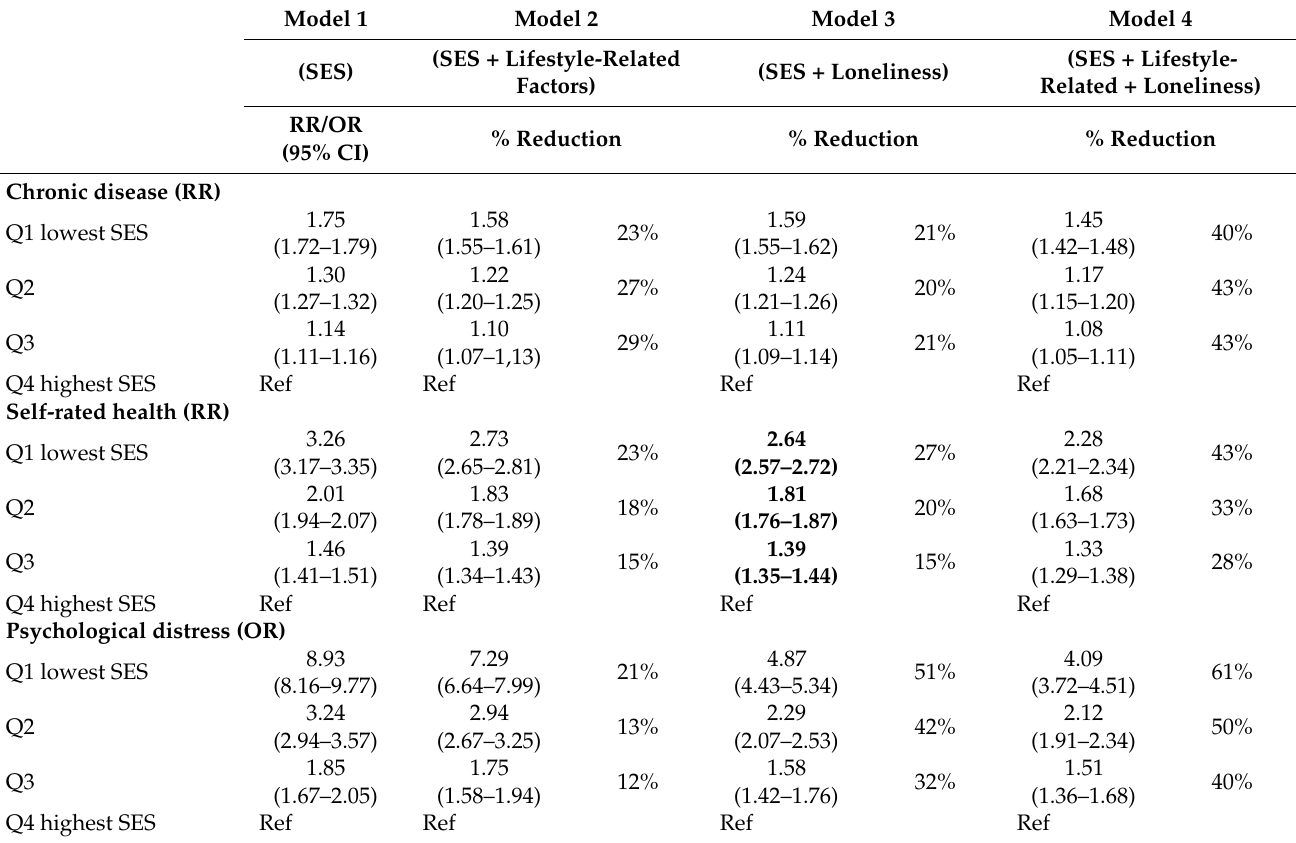
Table 2. Associations between socioeconomic groups and the three health outcomes, adjusted for demographic factors, lifestyle, and loneliness ( n =